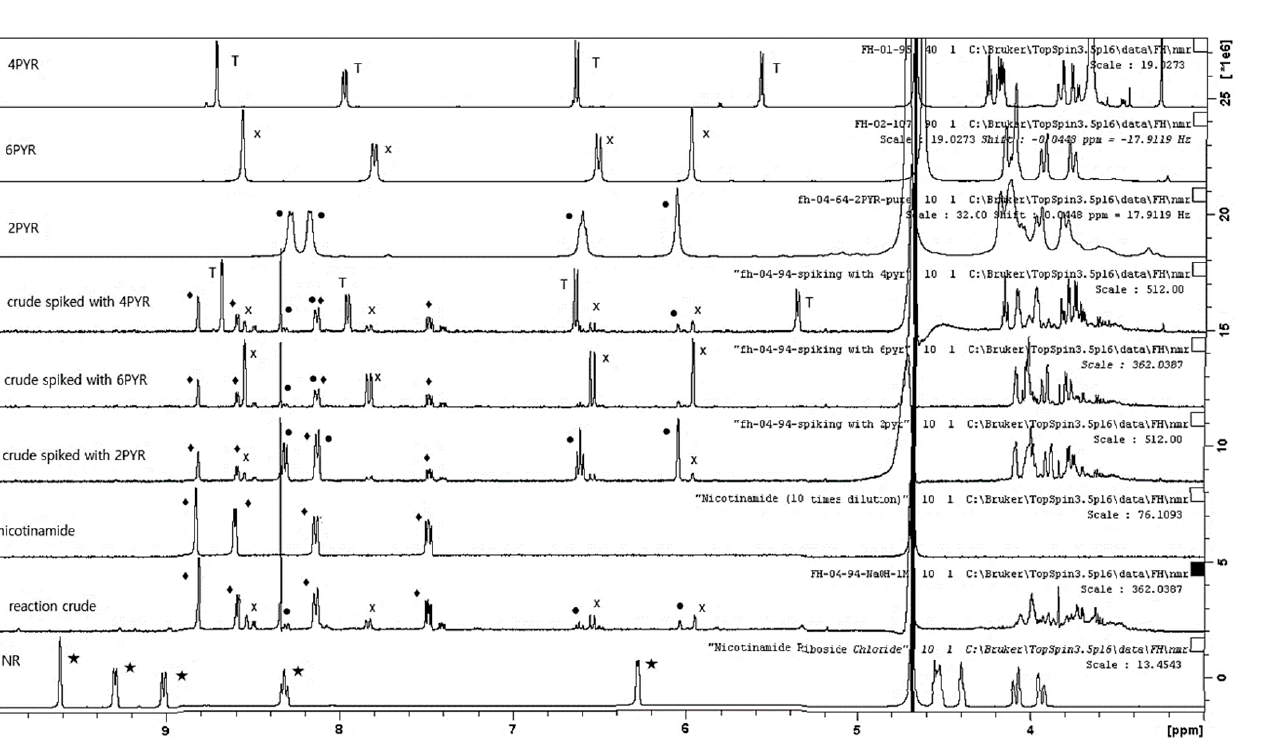
Figure 3. Fenton chemistry facilitates the formation of 2PYR and 6PYR from NR. Overlay 1H NMR of nicotinamide riboside (bottom spectrum) and crude reaction mixture (above). NR decomposes to nicotinamide under basic conditions (3rd spectrum up). The crude reaction mixture was spiked with each pyridone ribosides (4th–6th spectra). Pure PYR 1 H NMR spectra (7th–9th spectra). Only 2PYR and 6PYR are present in the reaction mixture. ● 2PYR ; x 6PYR; T 4PYR ; ★ Nicotinamide Riboside ; ♦ Nicotinamide.